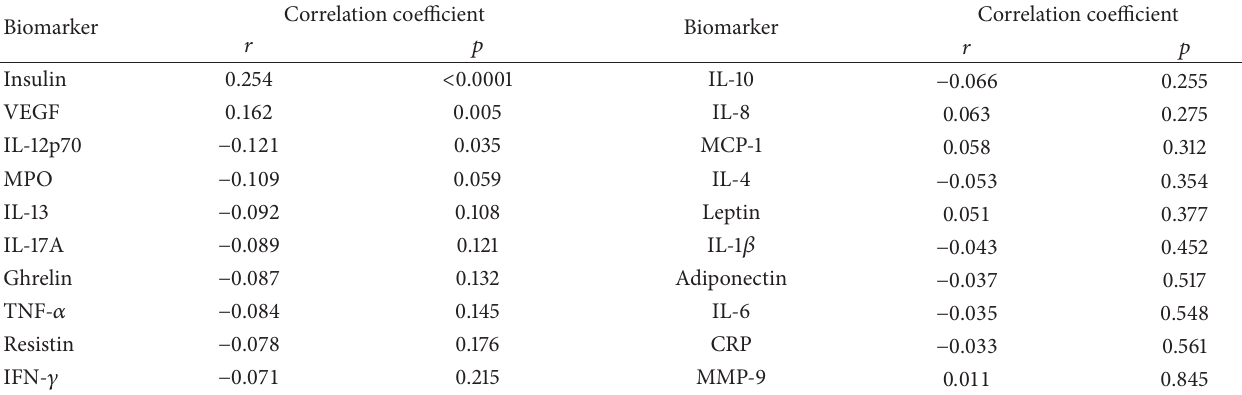
Table 2: Correlation coefficients ( 𝑟 ) with 𝑝 values between salivary glucose and salivary biomarkers sorted by ascending order of 𝑝 . Biomarker